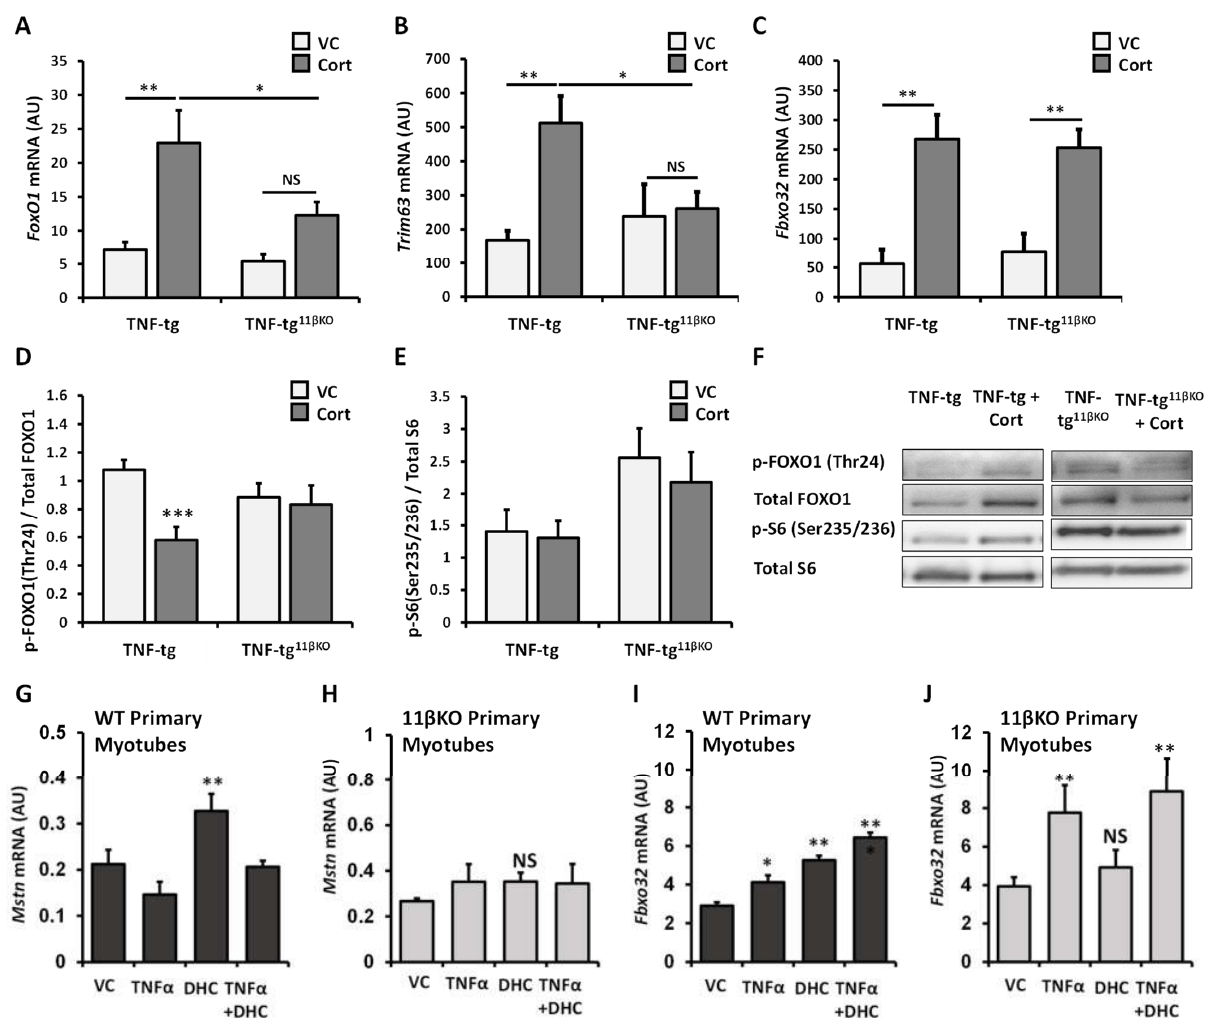
Figure 4. Gene expression (AU) of ( A ) Foxo1 , ( B ) Trim63, and ( C ) Fbxo32 determined by RT qPCR in muscle homogenates from TNF-tg, and TNF-tg 11βKO animals receiving either vehicle or corticosterone (100 µg/mL) in the drinking water for 3 weeks. ( D ) The p-FOXO1(Thr24)/Total FOXO1 and ( E ) p-S6(Ser235/236)/Total S6 ratios and ( F ) representative western blot staining after loading of 20 µg of protein and normalization to Ponceau staining in quadriceps for TNF-tg and TNF-tg 11βKO animals receiving either vehicle or corticosterone (100 µg/mL) in the drinking water for 3 weeks. Gene expression (AU) of ( G , H ) Mstn and ( I , J ) Fbxo32 in primary murine muscle cultures from WT and single mutant 11βKO animals treated with recombinant TNFα and/or dehydrocorticosterone (DHC) determined by RT qPCR. Values are expressed as mean ± SE, n = 6 per group for animal experiments and n = 3 per group for primary culture. Statistical significance was determined using two-way analysis of variance with Tukey post hoc analysis. * p < 0.05, ** p < 0.005, *** p < 0.001. WT, Wild type; 11βKO, 11β-HSD1 genetic deletion; VC, Vehicle Control; Cort, Corticosterone; DHC, Dehydrocorticosterone.